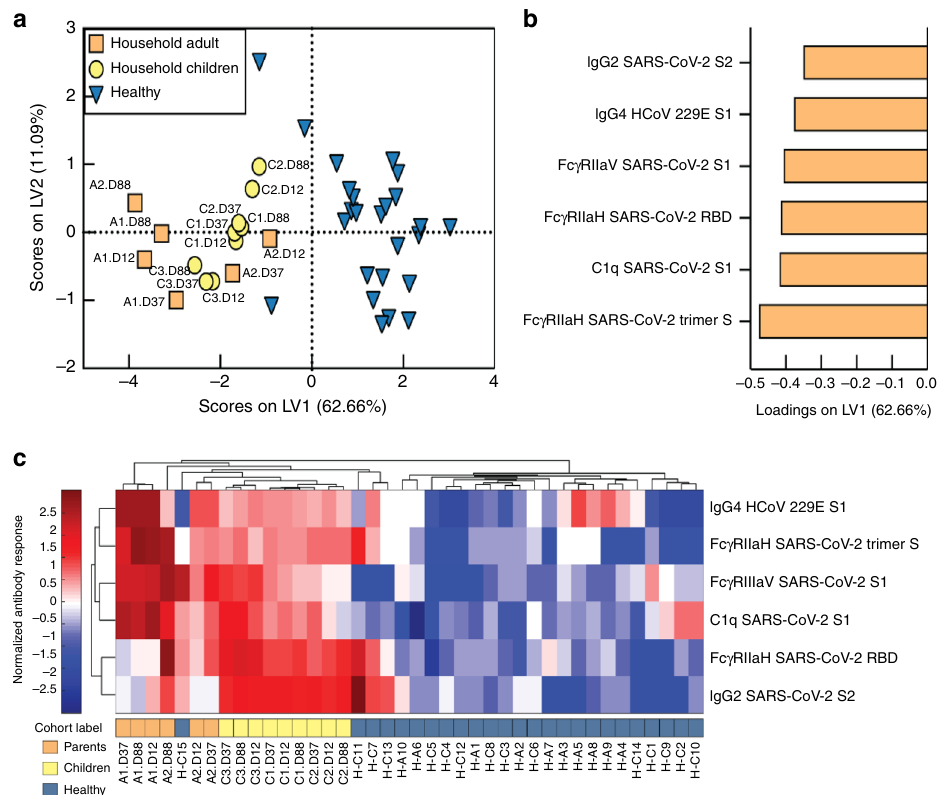
Fig. 4 Family of symptomatic SARS-CoV-2 PCR positive parents and SARS-CoV-2 PCR negative children have distinct serological responses compared to healthy individuals, characterized by elevated SARS-CoV-2 speci fi c responses. a PLSDA scores plot of healthy (blue triangles) vs family (circles) containing both SARS-CoV-2 PCR positive parents (orange) and negative children (yellow) exhibited 98.0% calibration and 96.0% cross-validation accuracy, with 62.7% of variance explained by LV1 (x-axis). Family member samples are labeled with A (adult) or C (child) with the day of sample collection listed after D. b PLSDA plot of LV1 loadings driving the separation of groups, where negatively loaded features are associated with the family members. c Hierarchical clustering of healthy individuals (blue) and family members (parents, orange; children, yellow) using a feature-selected serological signature, where red indicates a relatively high antibody response and blue a relatively low antibody response (z-score). Samples (x-axis) are labeled with H (healthy non-household members), and A (adult) or C (child). Day of sample collection is listed at the end of family member sample